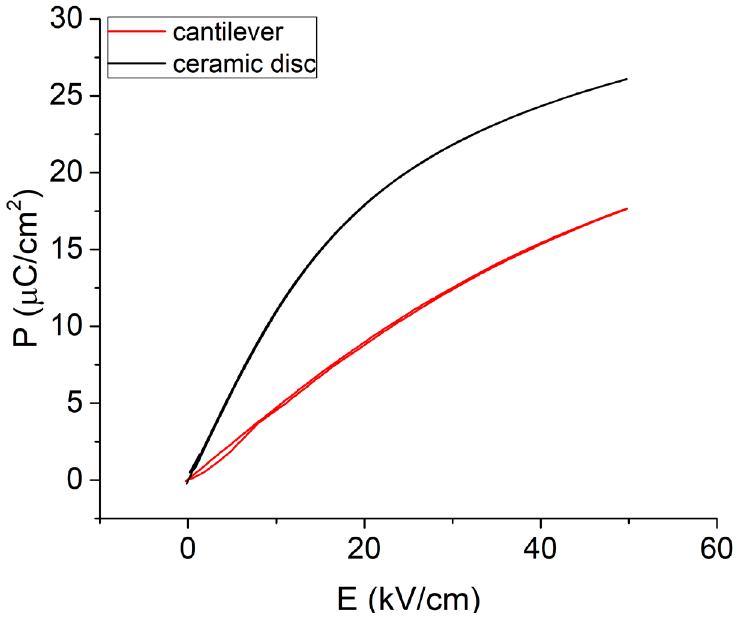
Figure 3. Unipolar polarization–electric-field ( P ( E )) loops of PMN ceramics and cantilevers, measured at 50 kV/cm and 1 Hz.